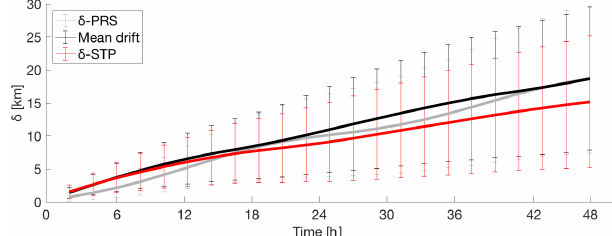
Figure 9. Time evolution of the mean separation distances δ STP and δ PRS [km] between the real and forecast trajectories using the truth and STP–PRS currents and the mean drift with the Red Sea HFR system data for July 2017 to October 2018. The mean drift of the truth forecasted trajectories is also computed for each simulation period (the means drift is considered the average of the distances moved by each particle during